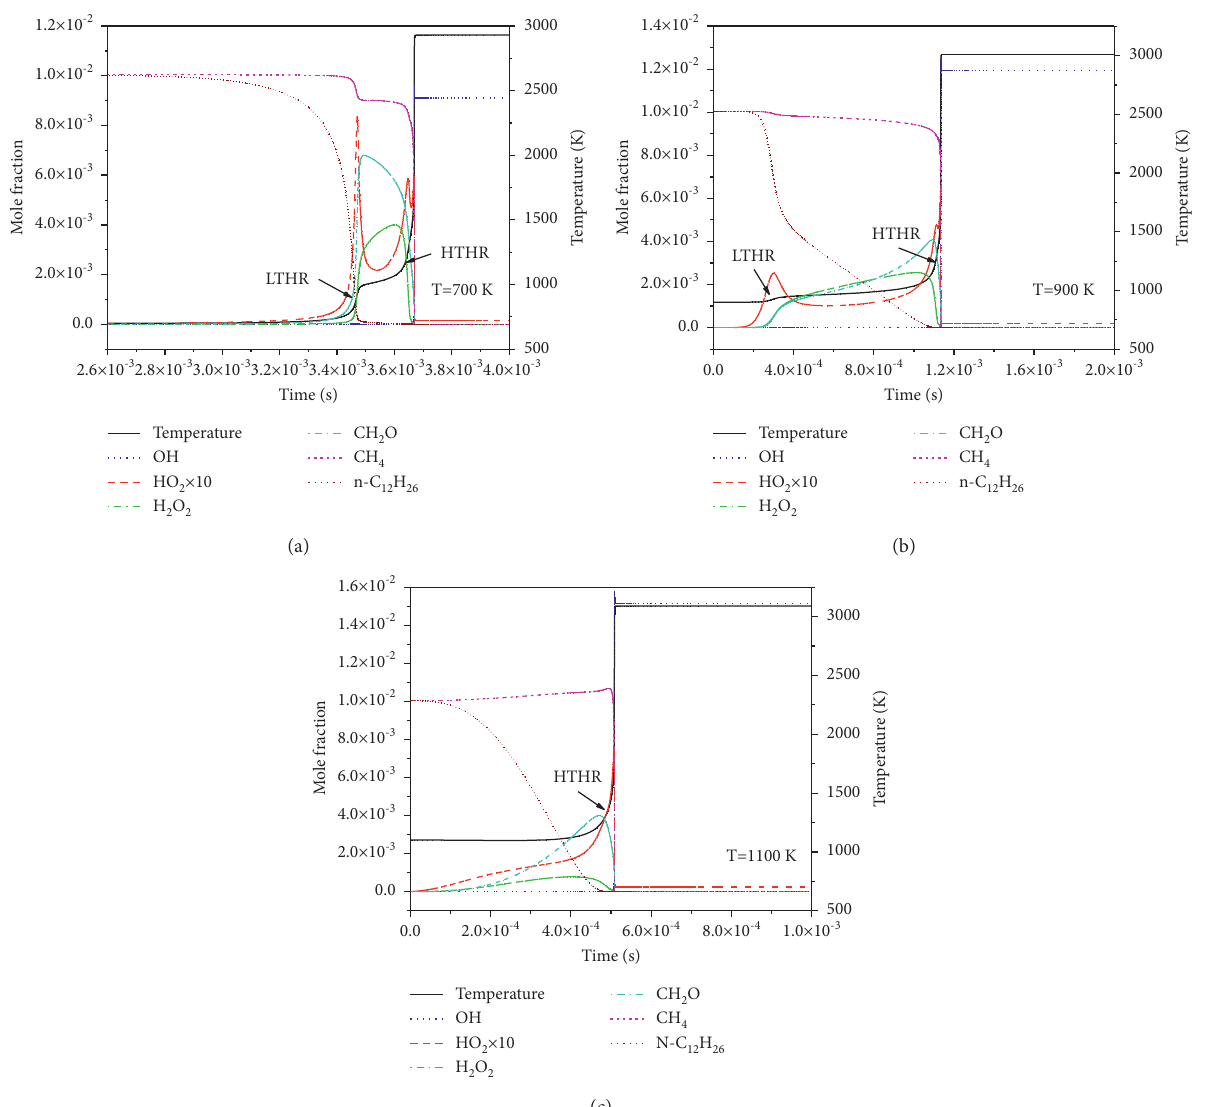
Figure 10: Species evolution of methane-n-dodecane mixtures at different initial temperatures at ϕ